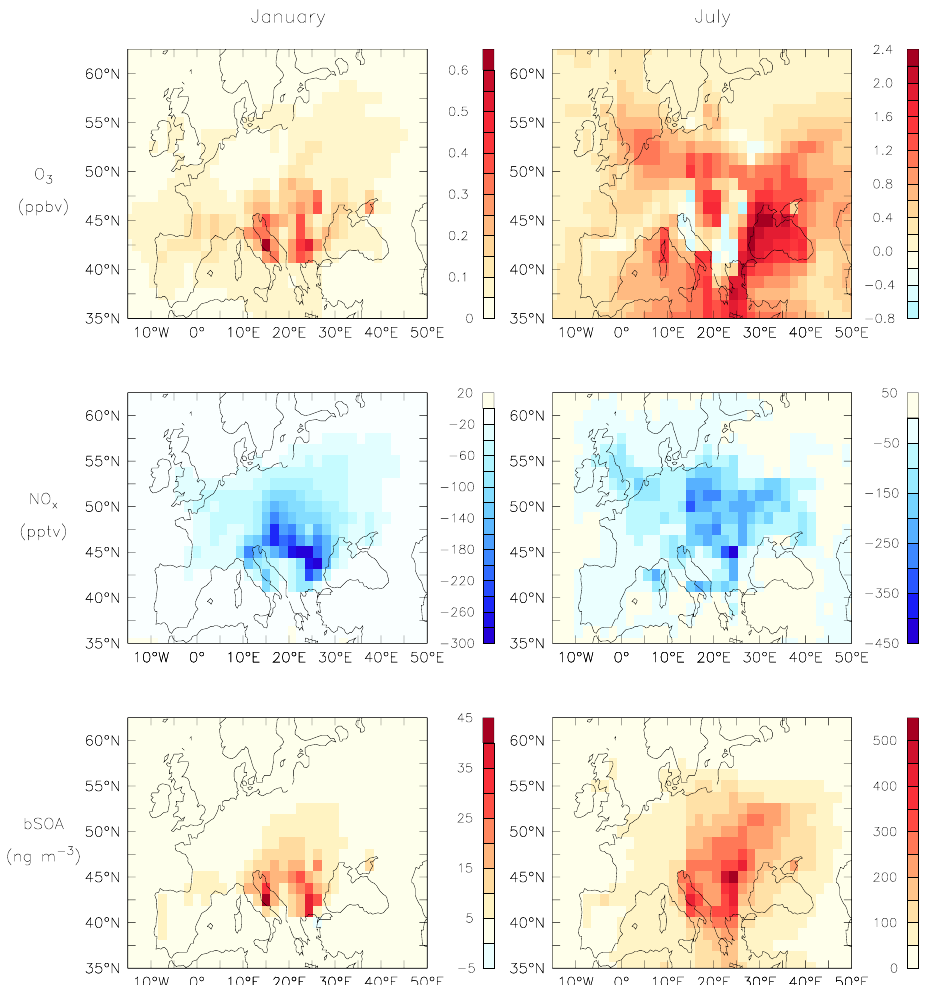
Fig. 4. Differences in monthly mean surface concentrations of ozone (top), NO x (middle) and SOA (bottom) for Europe in January (left) and July (right) for SRC vs. CTRL. Note change of scale from January to